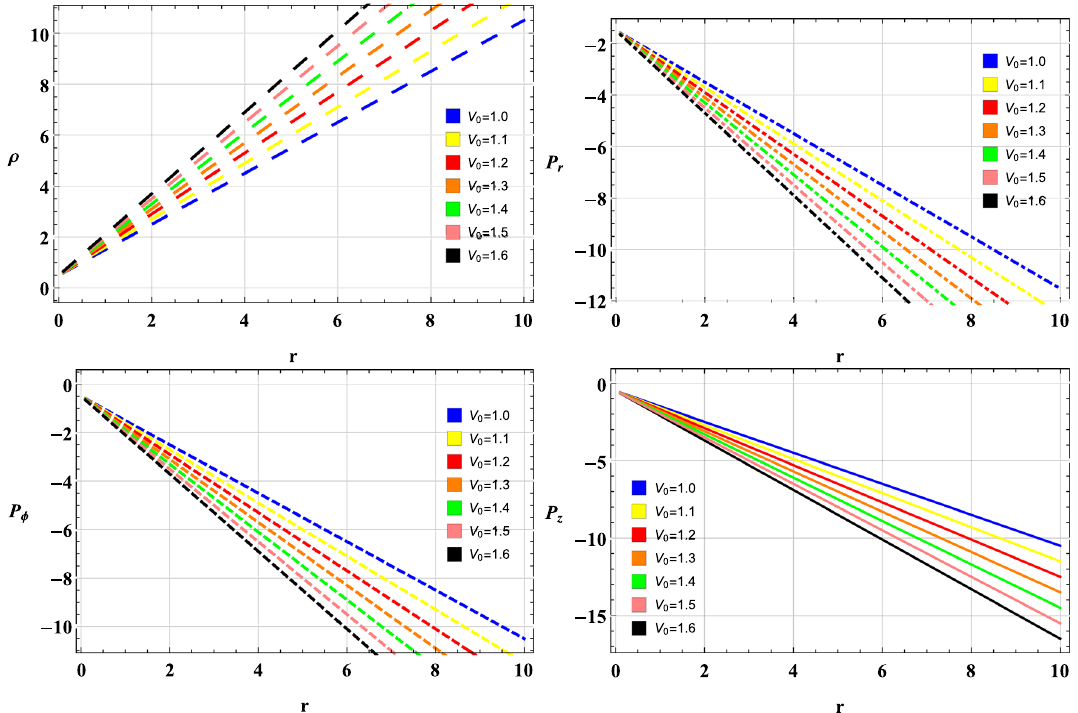
Fig. 5 The graphical variation of ρ (MeV/fm 3 ) , p r (MeV/fm 3 ) , p φ (MeV/fm 3 ) and p z (MeV/fm 3 ) is showed in this figure with respect to the radial co-ordinate r . CASE (B)